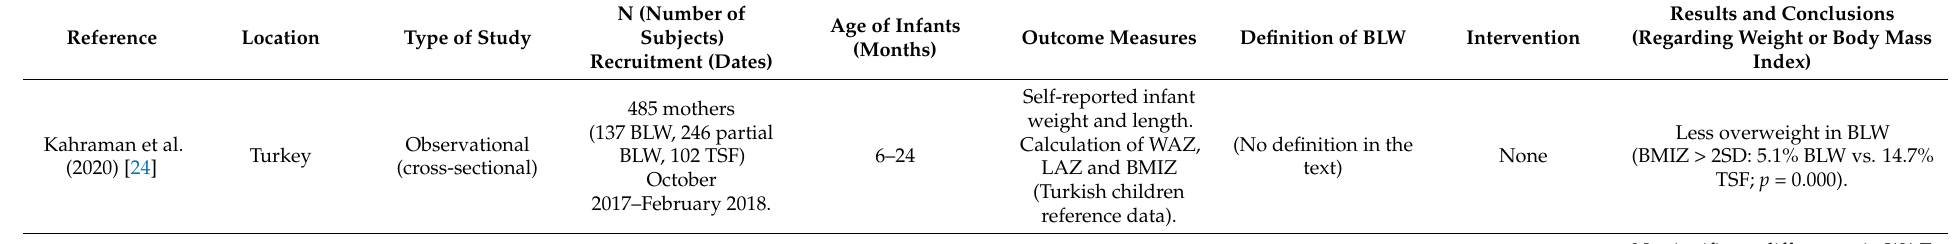
Table 2. Main characteristics of the studies included in the